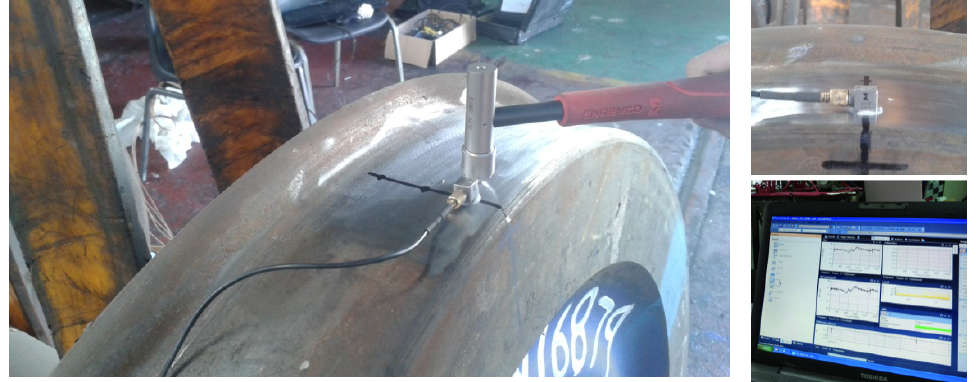
Figure 4. Experimental modal analysis (EMA) of D39200 locomotive wheel.